Question: What form of chart is displayed?
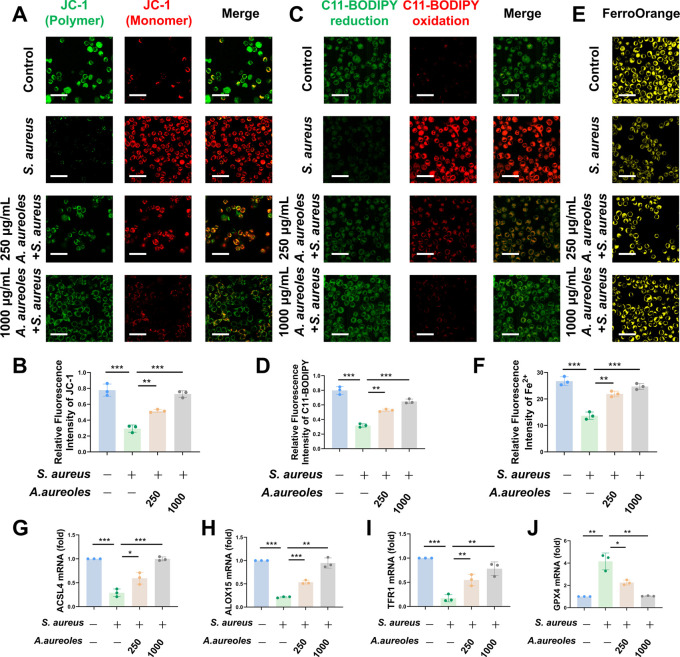
Answer: bar